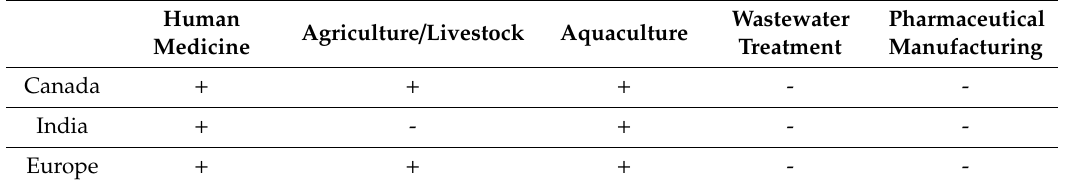
Table 1. Summary of policies in place to address antibiotic pollution and related risks. Human